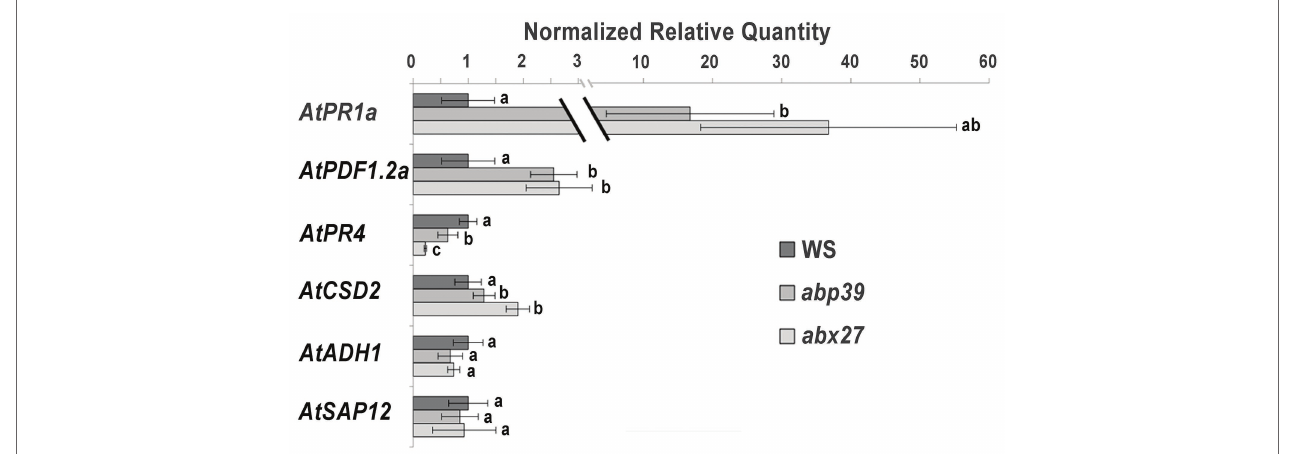
FIGURE 5 | AtGAPC1 and AtGAPC2 regulate expression of defense-associated genes in Arabidopsis. RT-qPCR was used to investigate expression of defense- and stress-associates genes in abp39 and abx27 mutant seedlings. The genes considered were AtPR1a ( At2g14610 ; salicylic acid (SA)-mediated defense response marker gene), AtPDF1.2a ( At5g44420 ; encoding ethylene- and jasmonate-responsive plant defenses), AtPR4 ( At3g04720 ; ethylene-responsive pathogenesis-related protein), AtCSD2 ( At2g28190 ; chloroplastic Cu/Zn superoxide dismutase), AtADH1 ( At1g77120 ; catalyzing the reduction of acetaldehyde with NADH as reductant), and AtSAP12 ( At3g28210 ; stress-associated protein). AtOXA1 ( AT5G62050 ) and AtUBP22 ( AT5G10790 ) were used as internal controls. Data are presented as means ± standard deviation (SD) from three biological replicates. Different letters indicate statistically significant differences, * p < 0.05, Wilcoxon sign-rank